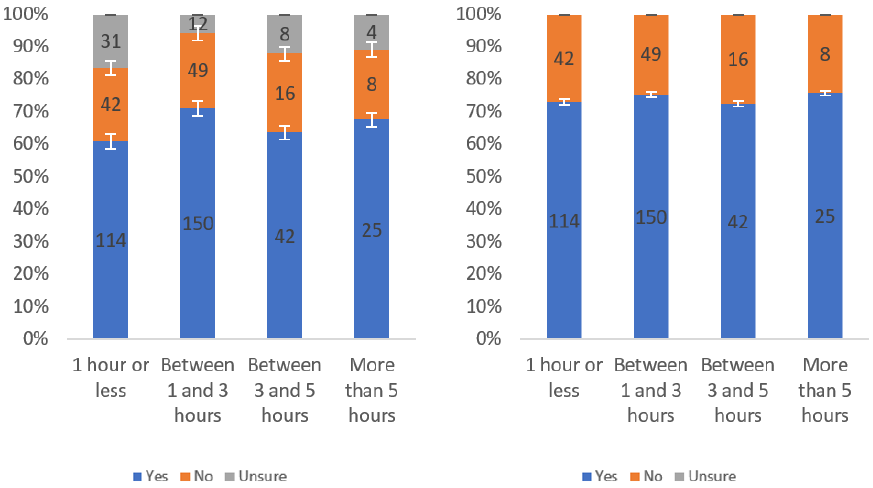
Figure 25. Responses regarding label helpfulness by internet usage level including ( left ) and ex- cluding ( right ) unsure